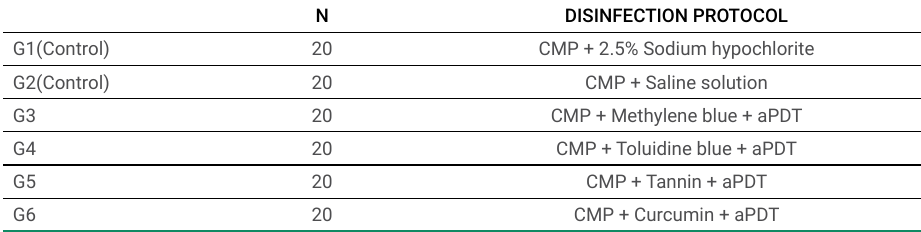
Table 1. Groups distribution